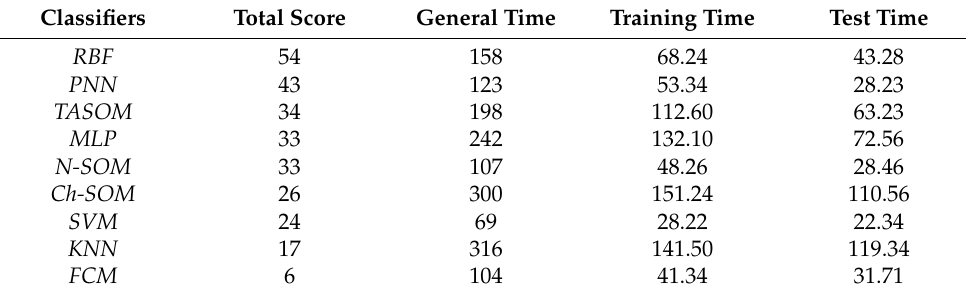
Table 6. Scores and Average Time of all evaluated Classifiers.